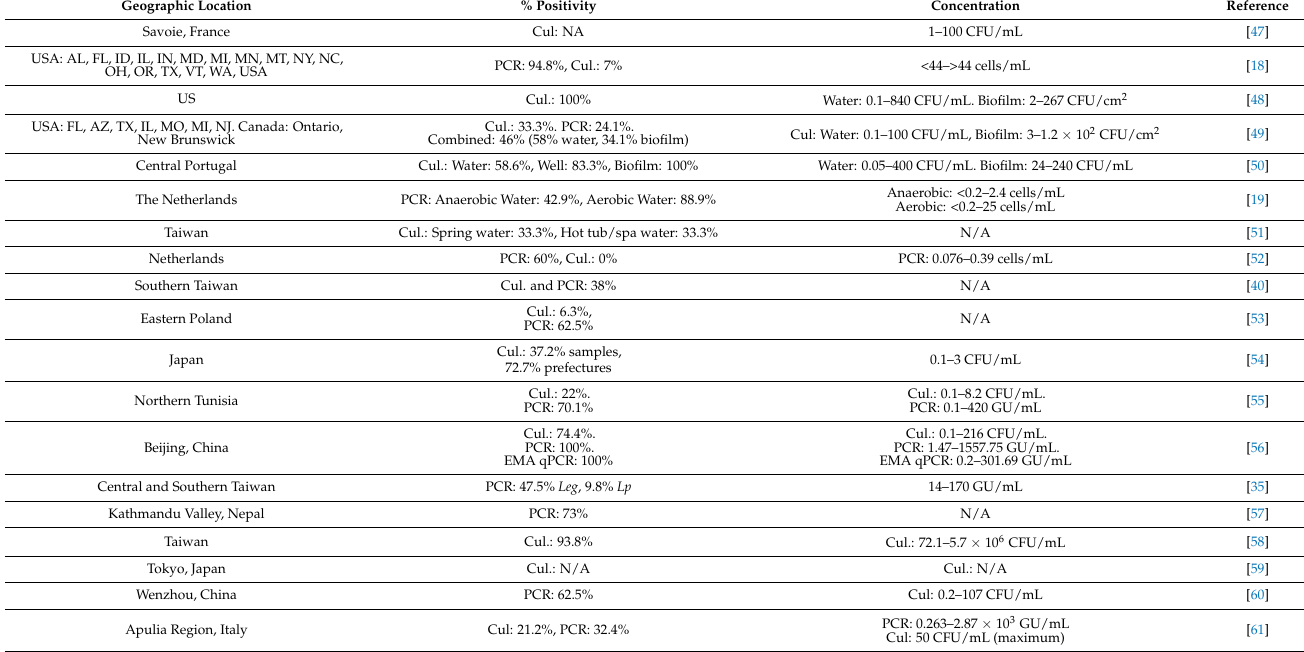
Table 2. Occurrence of Legionella in Ground